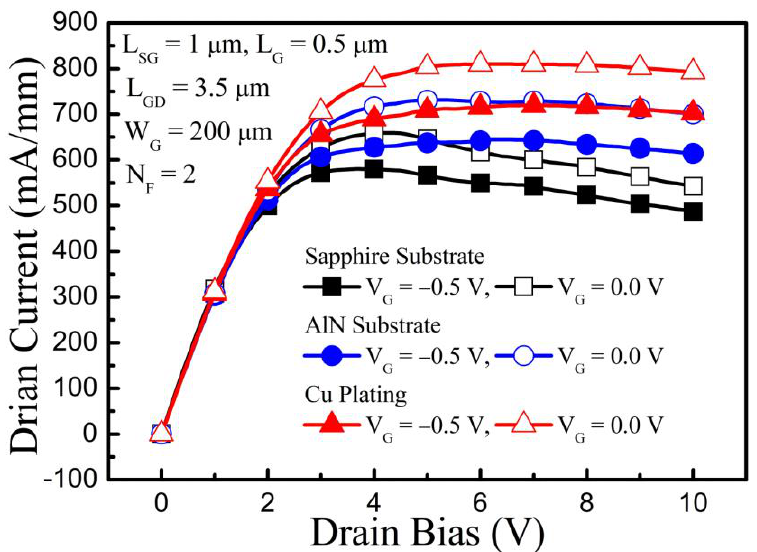
Figure 2. Output characteristics of GaN-based HEMTs operated on sapphire substrate, AlN substrate and Cu film. Drain current vs. Drain bias.